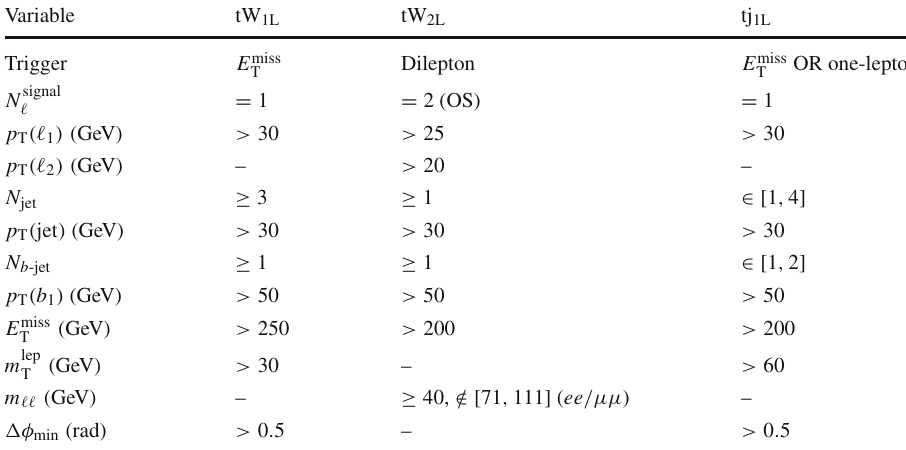
Table 2 Summary of the trigger and preselection requirements for the three analysis channels. Opposite-sign leptons are indicated as (OS). Events with extra baseline leptons are